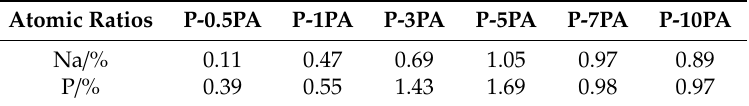
Table 1. Determined atomic rates of sodium and phosphorous by EDX analysis. Atomic